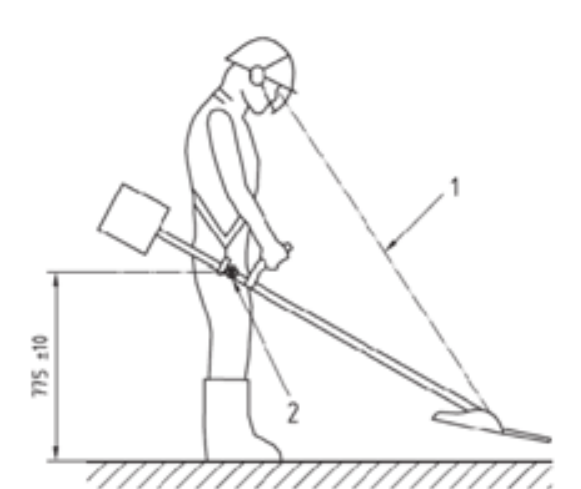
Figure 1. Operating position (ISO 22867:2008; 1-operator’s view towards the cutting tool, 2-centre of